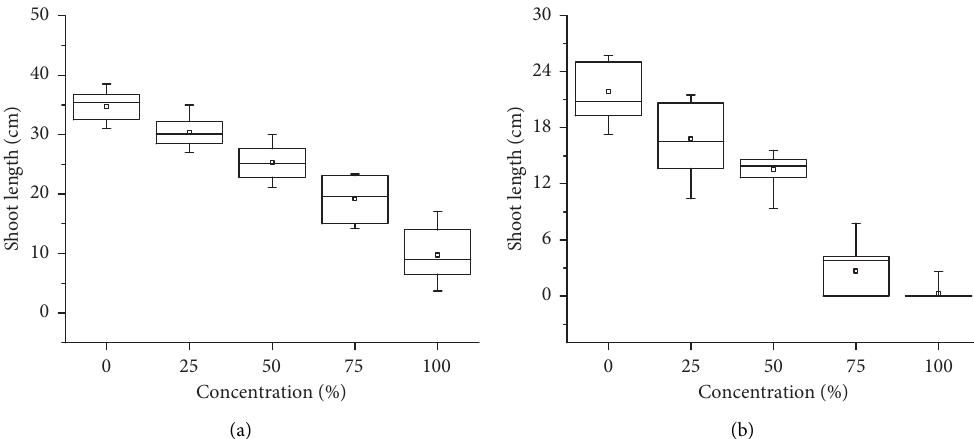
Figure 2: Shoot length of germinated P. vulgaris (a) and O. sativa (b) seedlings in screen house experiment after 7 and 14 days of treatment with S. suaveolens extracts, respectively.